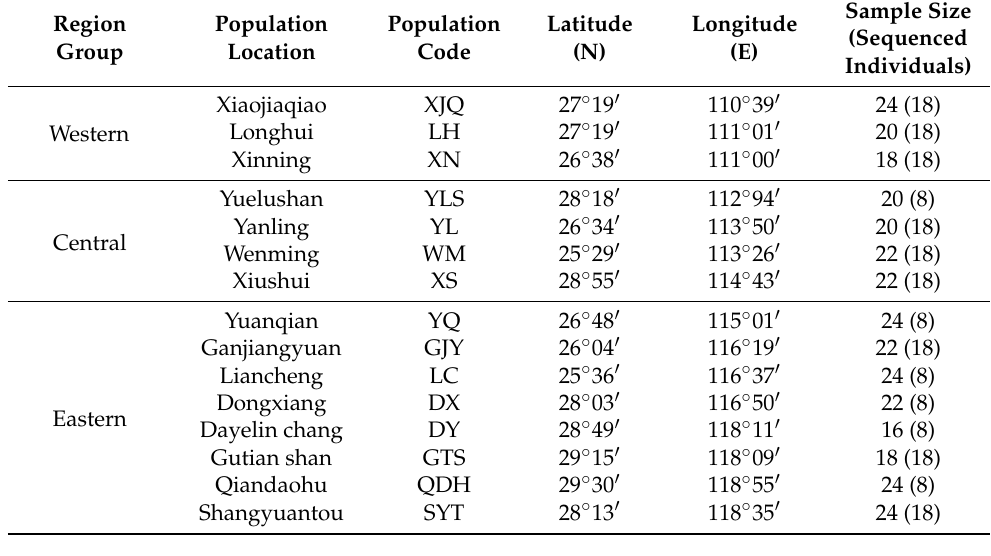
Table 1. Location and sample size of 15 Castanopsis sclerophylla populations.